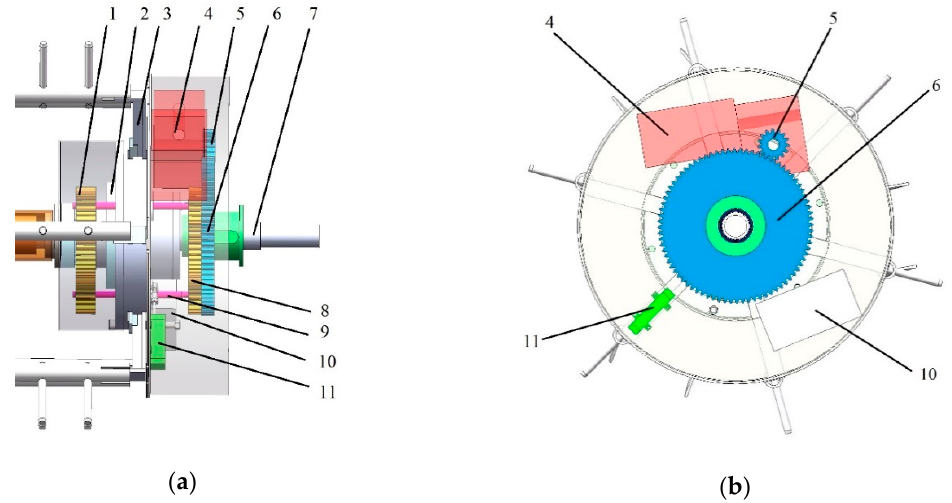
Figure 5. Electronic control self-locking device, 1. The first planetary gear set, 2. Constant speed spiral disc, 3. Claw, 4. Motor, 5. Motor gear, 6. Central gear, 7. Main shaft, 8. The second planetary gear set, 9. Connecting shaft, 10. Driver, 11. Displacement sensor: ( a ) Side view of electronic control self-locking device; ( b ) Front view of electronic control self-locking device.